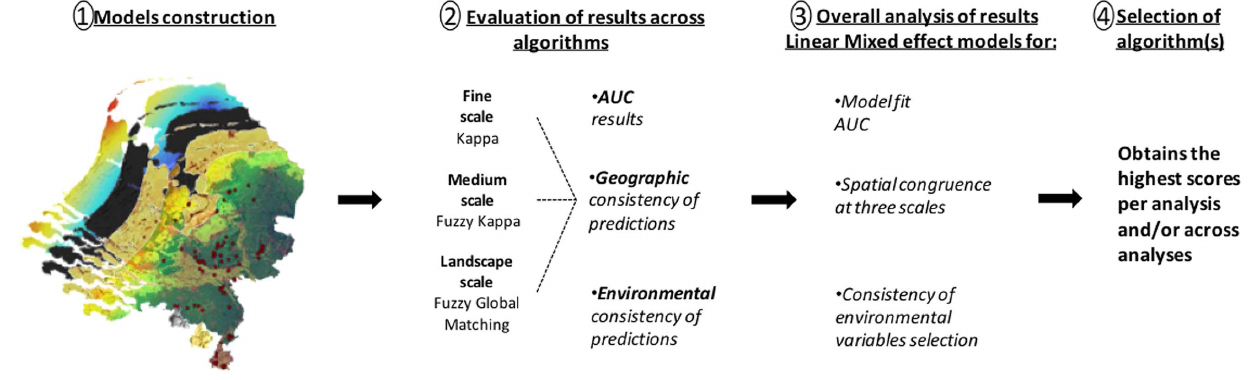
Figure 4. SDM’s analysis framework. Framework for analysing the algorithms adequacy for modelling our species distribution by means of model fit, binary predictions similarity and selection of variables importance. These results are analysed across algorithms by means of Linear Mixed Effects models (LME), which will aid in the selection of the most suitable algorithm for modelling our species distributions. doi:10.1371/journal.pone.0063708.g004 PLOS ONE |